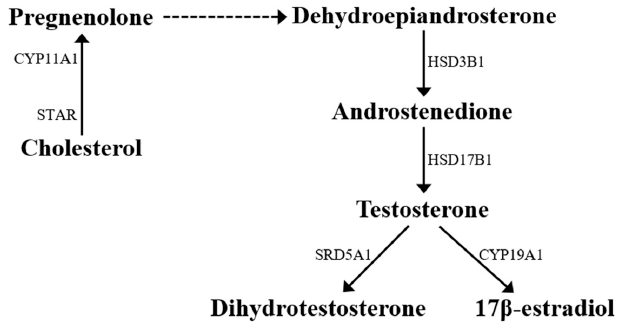
Figure 2. Sex steroid biosynthesis pathway. In Leydig cells cholesterol is translocated by STAR to the inner mitochondrial membrane, where it is converted into pregnenolone by P450 cholesterol side-chain cleavage (CYP11A1). Next in the smooth endoplasmic reticulum, pregnenolone is converted to dehydroepiandrosterone (dashed line) and then androstenedione by 3 β -hydroxysteroid dehydrogenase (HSD3B1). Then, 17 β -hydroxysteroid dehydrogenase (HSD17B3) catalyzes the conversion of androstenedione to testosterone which finally is converted into 5 α -dihydrotestosterone by 5 α -reductase (SRD5A1), or into 17 β -estradiol by cytochrome P450 aromatase (CYP19A1).